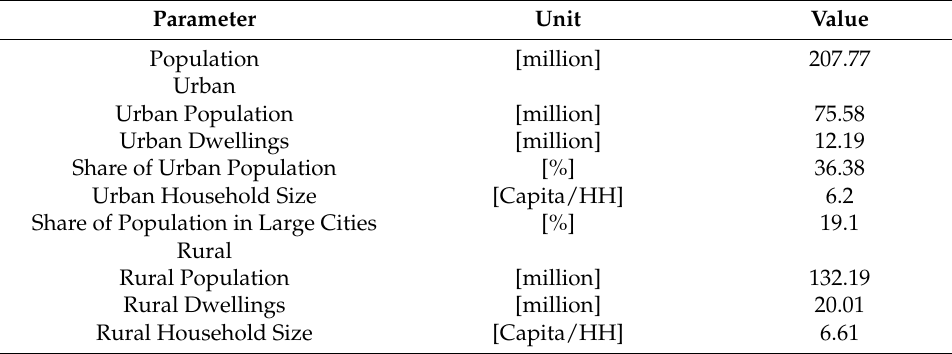
Table 6. Basic demographic data [35].